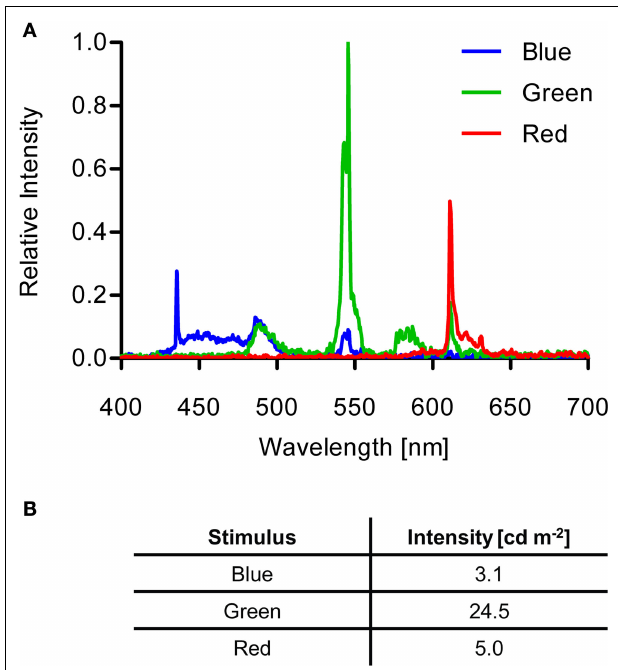
FIGURE 2 | Visual stimulus properties. (A) Spectra of blue, green and red stimuli generated by the LCD screen. (B) Intensities of the different light